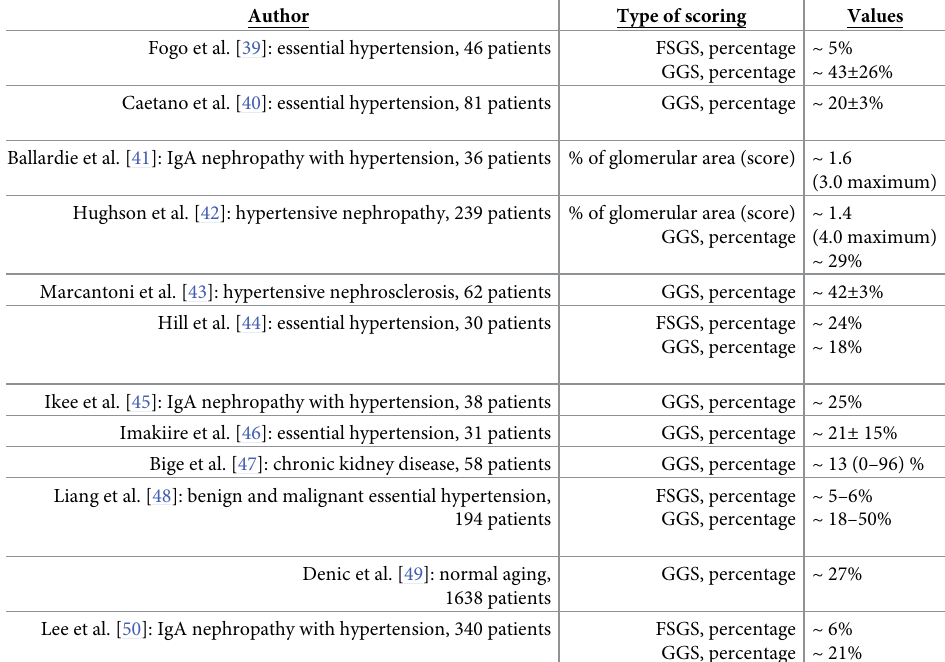
Table 1. Commonly accepted criteria for hypertensive glomerulopathy assessment enable quantification and comparison among human studies.